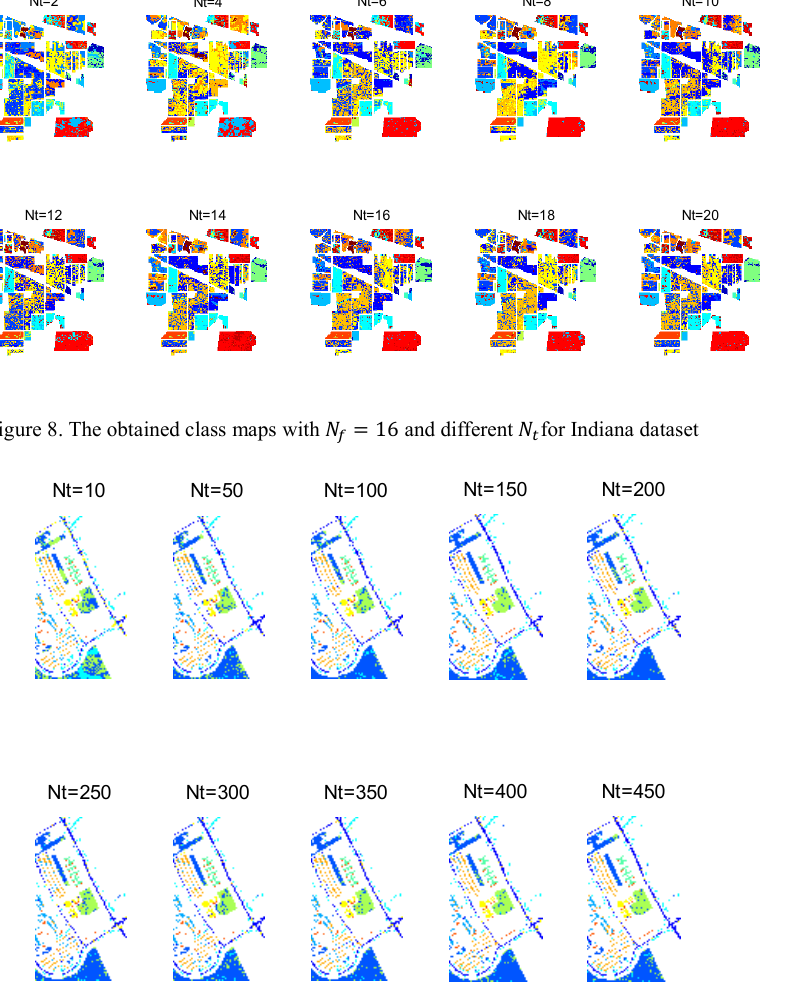
and different (cid:13) for Pavia university dataset 4 = 20 3